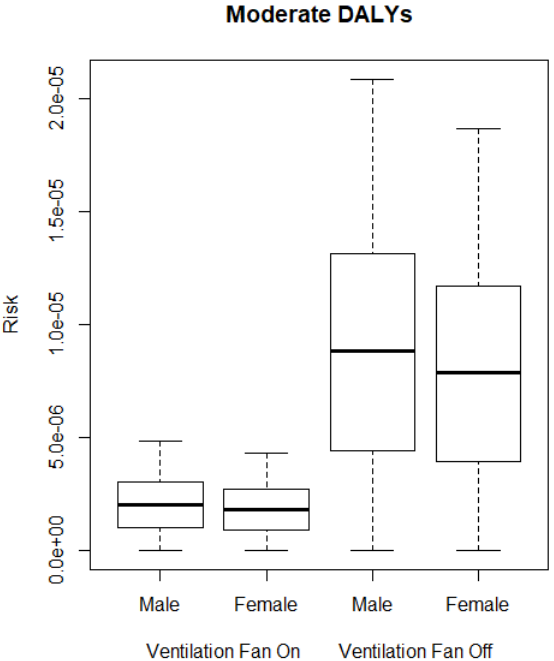
Figure 3. Moderate disability adjusted life years (DALYs) for male and female miners.